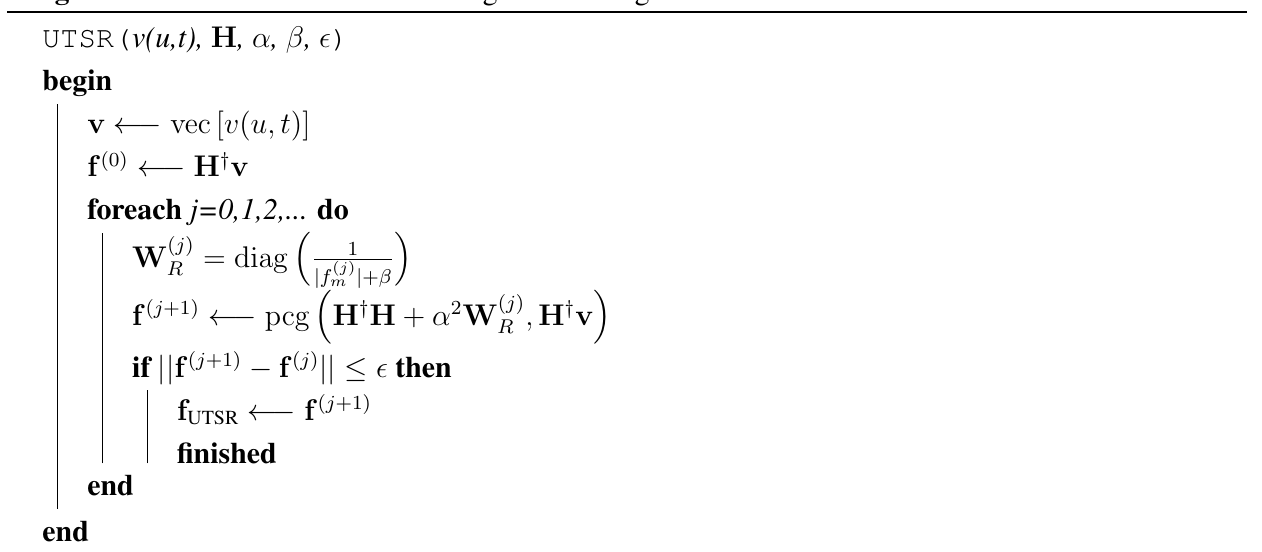
Algorithm 1. Pseudocode of UTSR algorithm using